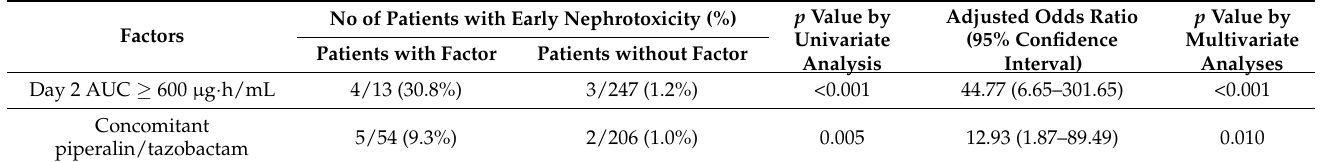
Table 3. Variables associated with early nephrotoxicity in univariate and multivariate